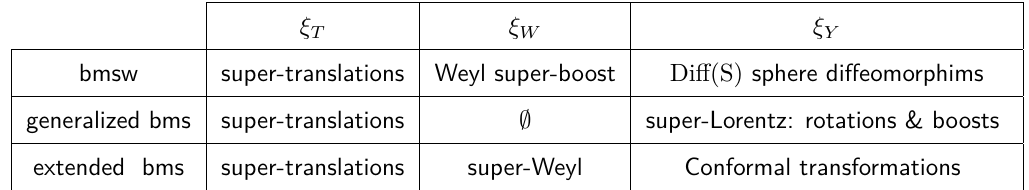
Table 2 . Comparison of the extended, generalized BMS and BMSW generators. The generalized BMS generators are called super-Lorentz transformations, following [18, 100]. They are obtained from BMSW by fixing the Weyl rescaling in terms of the sphere diffeomorphism to preserve the met- ric scale. One usually calls super-rotations the area-preserving diffeomorphisms while the Lorentz super-boosts refer to transformations that are divergence-full, D A Y A 6 = 0 . In bmsw we have a finer group structure and the Weyl super-boosts are left free. Note that the Weyl super-boosts are, unlike Lorentz super-boosts, genuine boosts normal to the sphere. The Weyl super-boosts decouple in the extended BMS